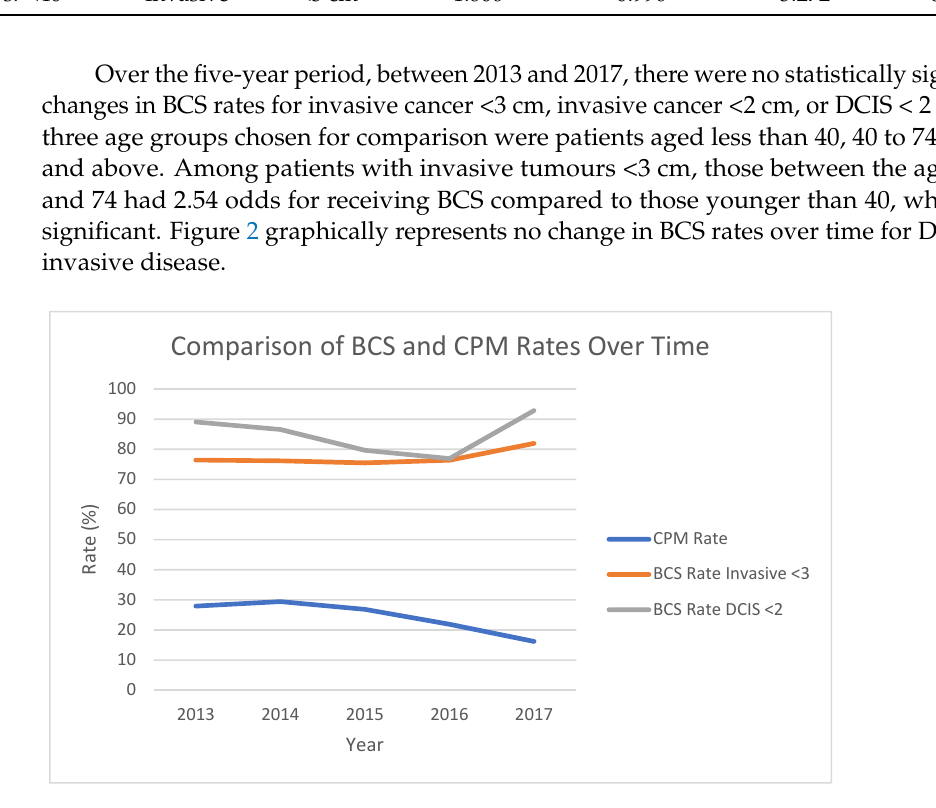
Table 3. Time and age trends for BCS rates by tumour type (invasive cancer or DCIS) and size (cm). Comparison vs. Predictor